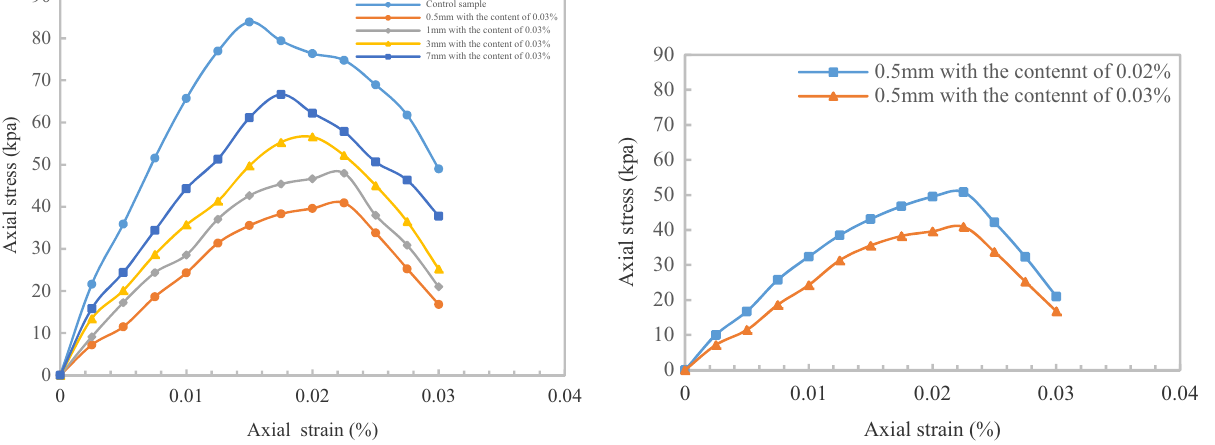
Figure 8: The stress – strain curves of di ff erent reinforcement ratios with EPS particle size of 0.5 mm.